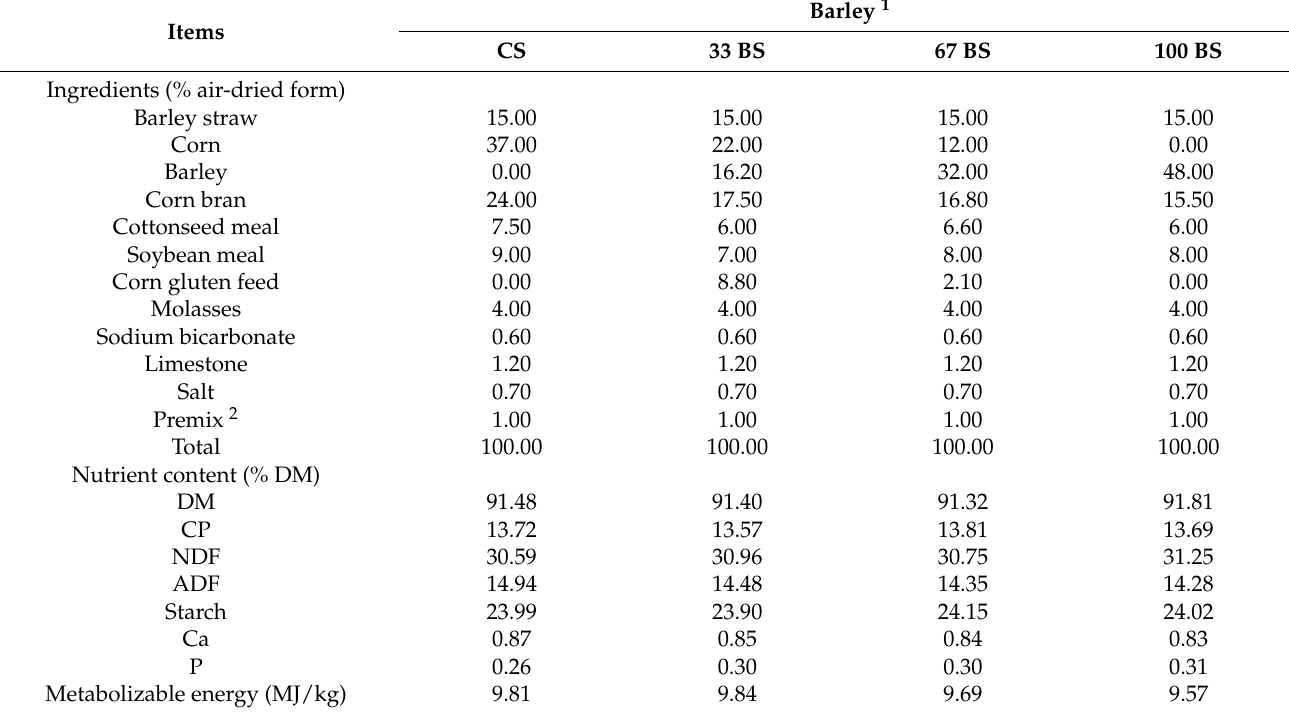
Table 1. Ingredients and chemical composition of